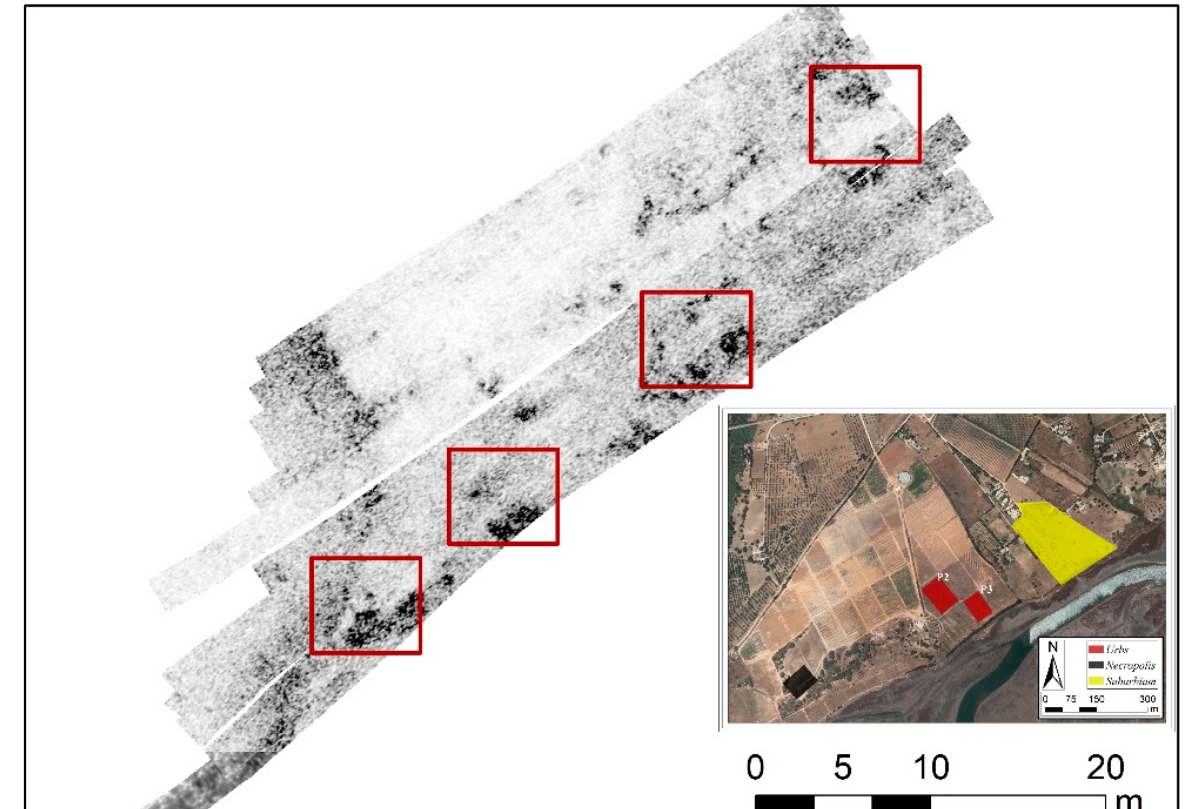
Figure 9. Groups of alterations in the GPR survey of the necropolis area.